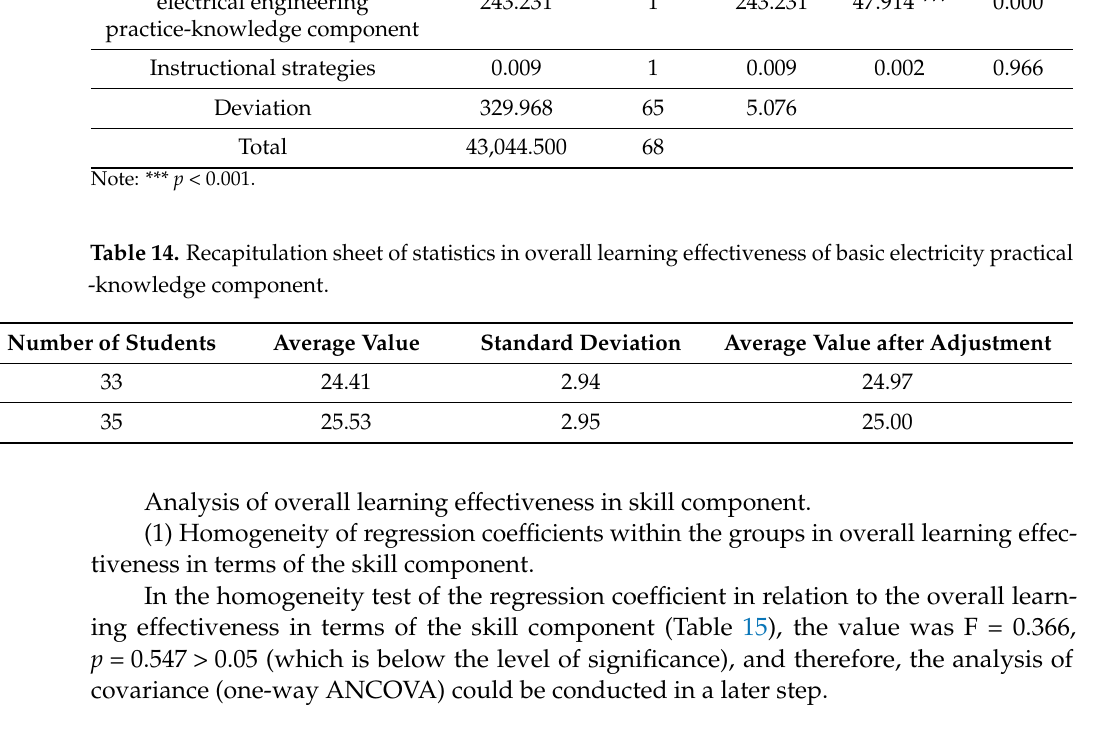
Table 15. Homogeneity test of regression coefficient in overall learning effectiveness in terms of the skill